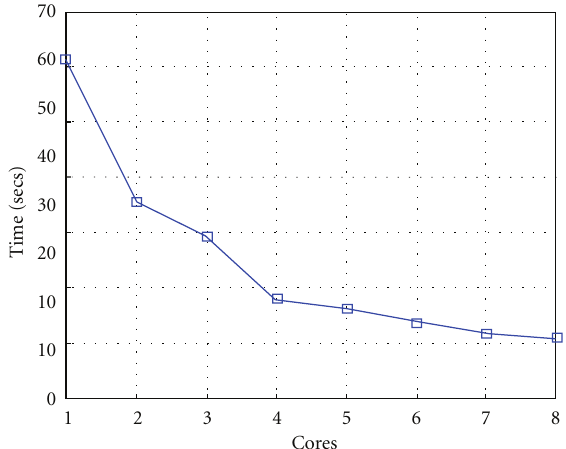
Figure 15: Test 1: Algorithm I: Total execution time versus the number of cores. Δ τ I = 0 .